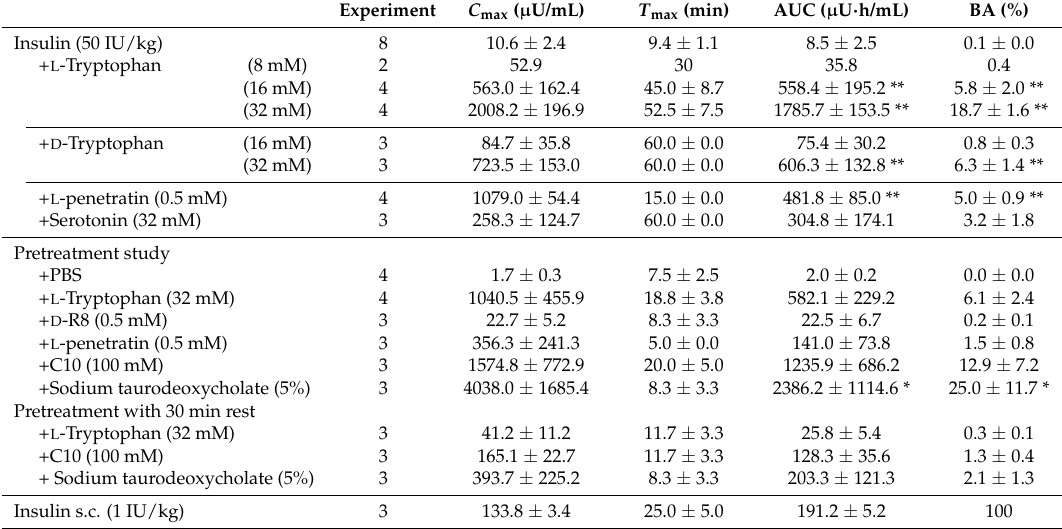
C max , the maximum concentration; T max , the time to reach the C max ; AUC, the area under the curve; BA, relative bioavailability compared to subcutaneous injection. Each data point represents the mean ± SEM of N =3–8, except for the group with L -tryptophan (8 mM, N = 2). * p < 0.05, ** p < 0.01, significantly different with corresponding control insulin (50 IU/kg).